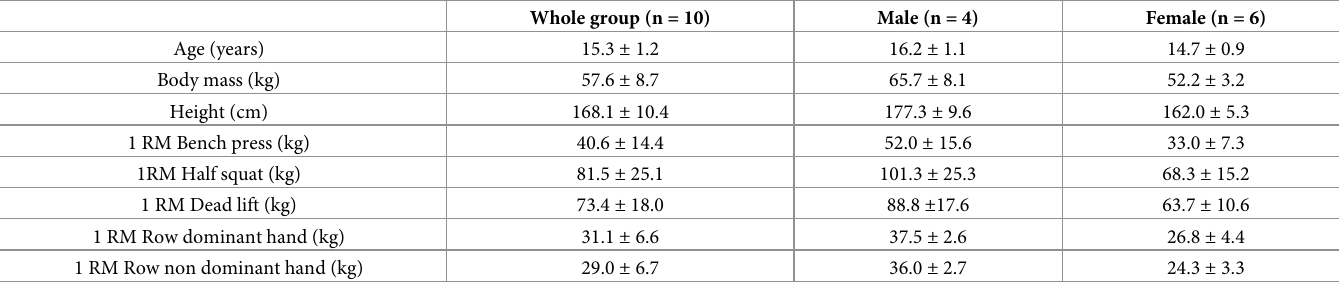
Table 1. Participant characteristics.